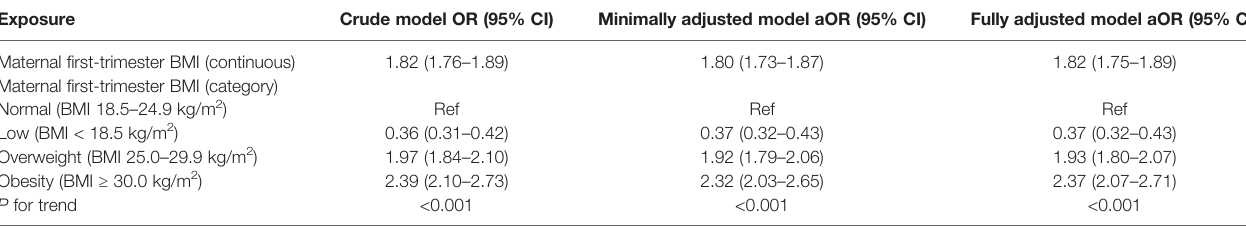
TABLE 2 | Relationship between maternal fi rst-trimester BMI and macrosomia in different models.